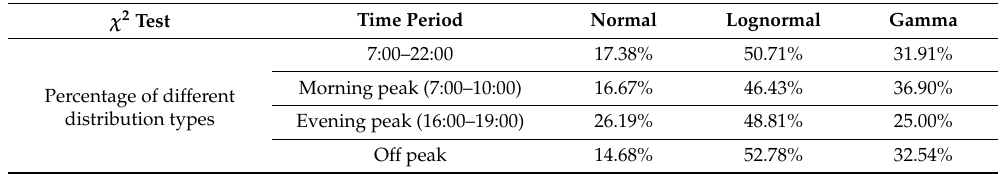
Table 1. Best-fit results for three types of turning delay distributions at 5% significant